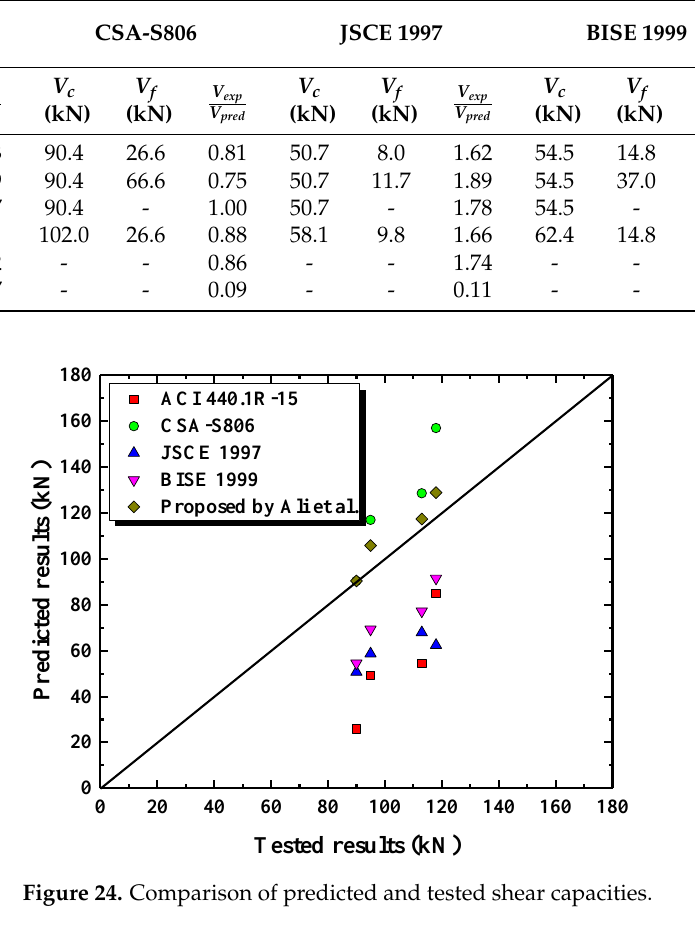
Table 5. Comparison of predicted and tested shear capacities.